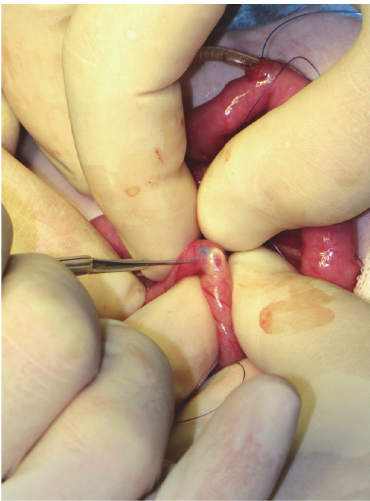
Figure 3: Because the small bowel in this very young patient (2 months) was too narrow to insert the needle over a distance of at least 8 cm without piercing the bowel wall inadvertently, we inserted the feeding tube equipped with a guide thread into the bowel lumen. An incision was made at the antimesenteric side of the jejunum loop at the planned exit site of the guide thread.